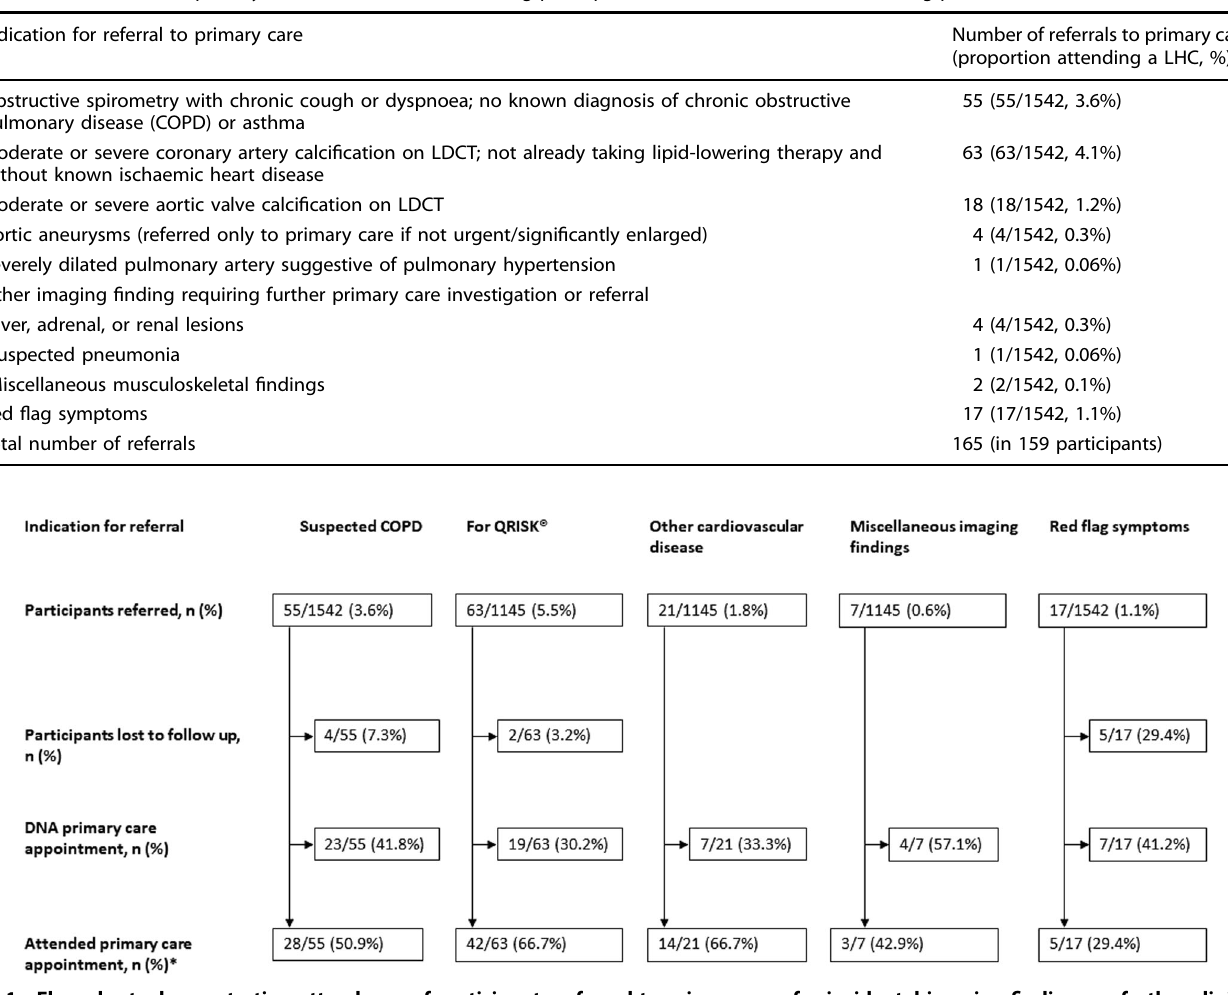
Fig. 1 Flow charts demonstrating attendance of participants referred to primary care for incidental imaging fi ndings or further clinical assessment following a LHC. For participants referred, the denominator is the number of participants having a LHC (where 1542) or the number of participants having a LDCT scan (where